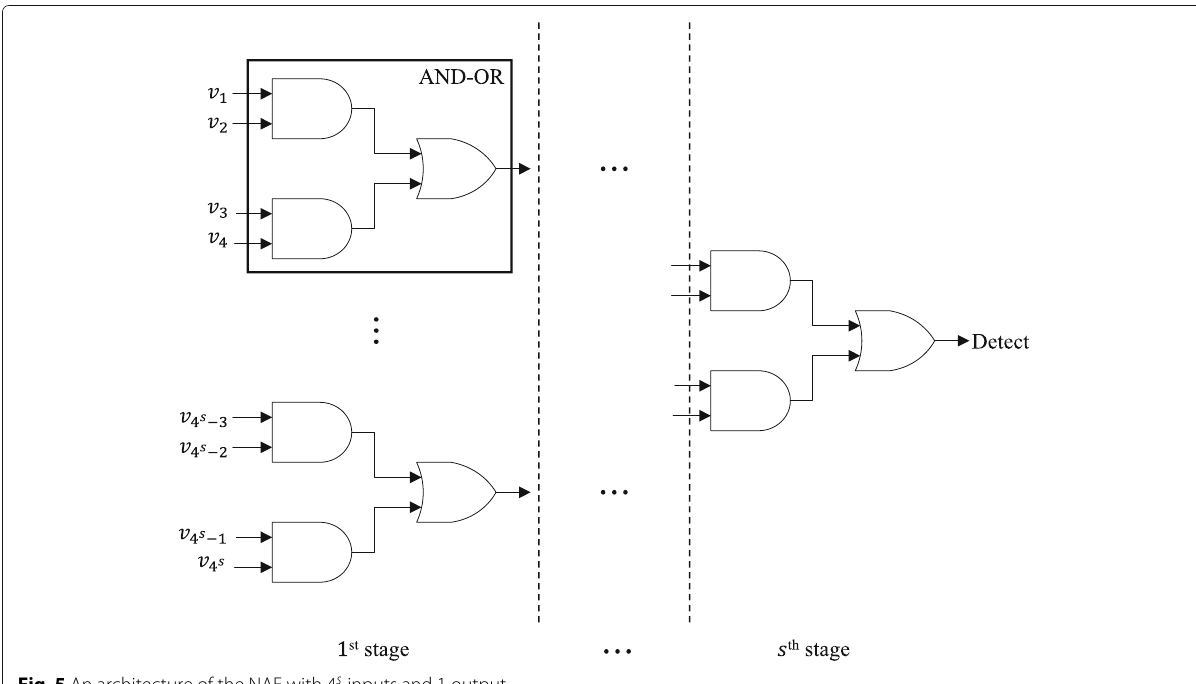
Fig. 5 An architecture of the NAE with 4 s inputs and 1 output